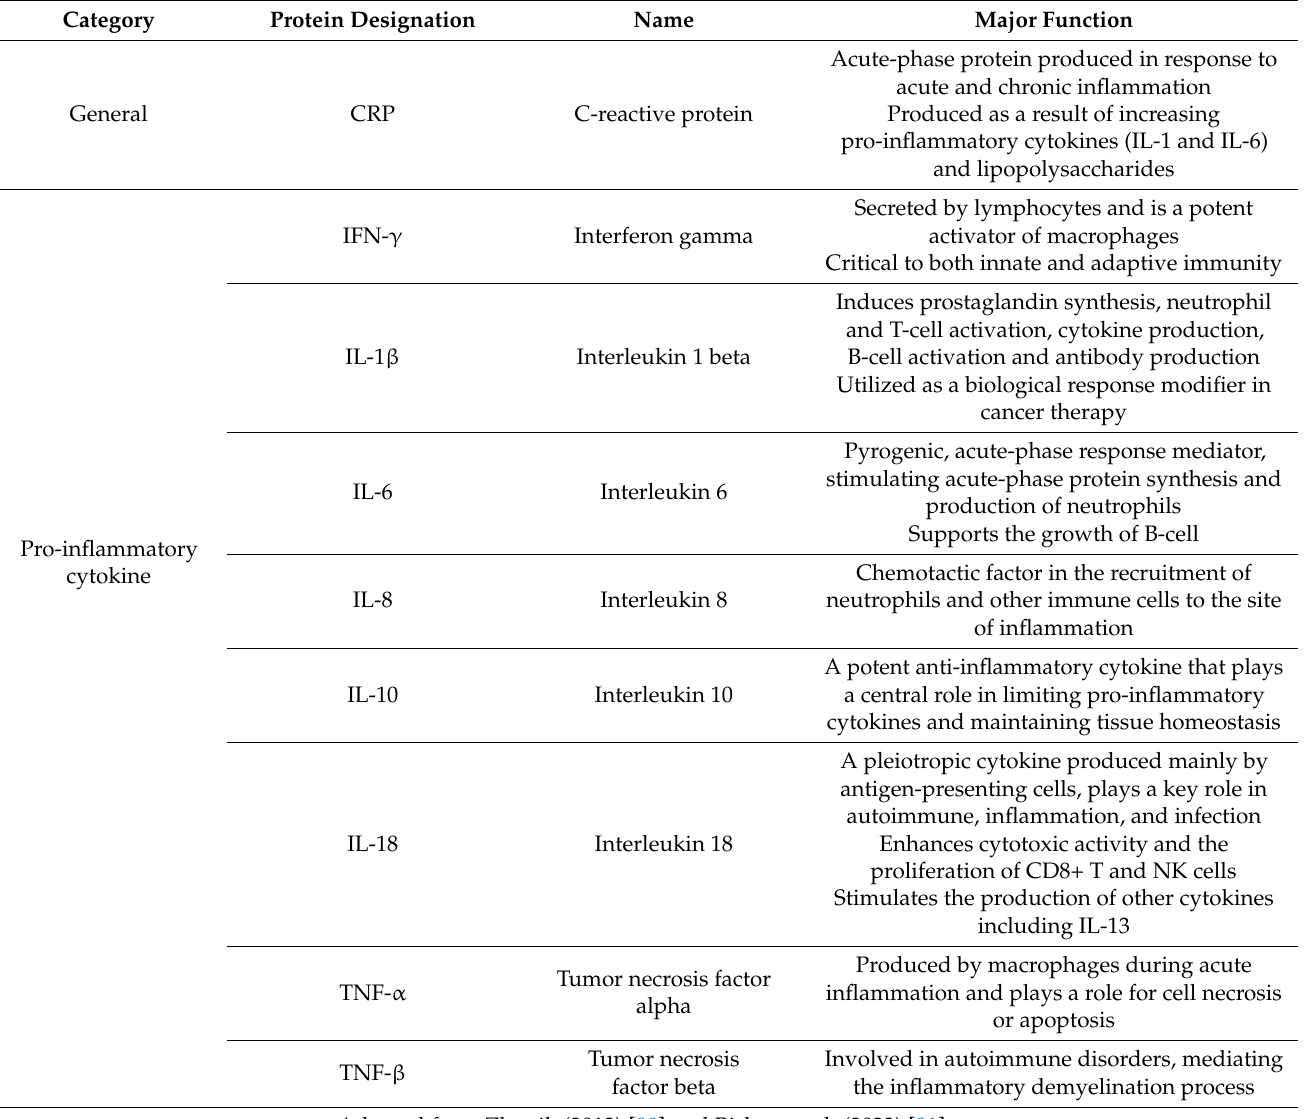
Table 1. Commonly investigated inflammation-related cytokines in neuropsychiatric